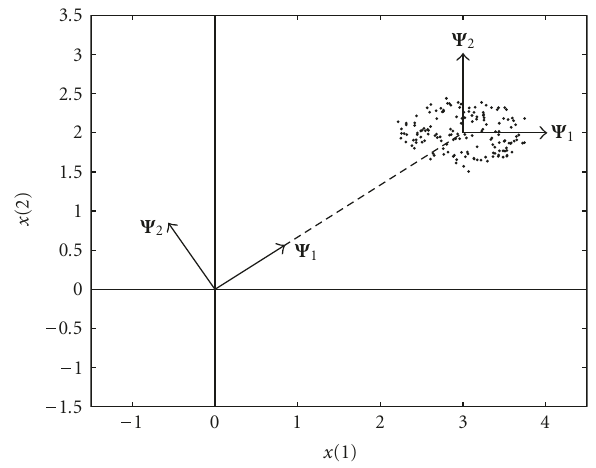
Figure 2: Eigenvectors ψ and ψ for N = 2, representing the di- 1 2 rections to which the data should be projected (transformed) in or- der to produce the principal components of the displayed data set. Eigenvectors with origin at [0 0] result from non-zero mean data, whereas eigenvectors with origin at the gravity center of the data re- sult from data when mean is subtracted; note that either variance or energy is maximized depending on the case